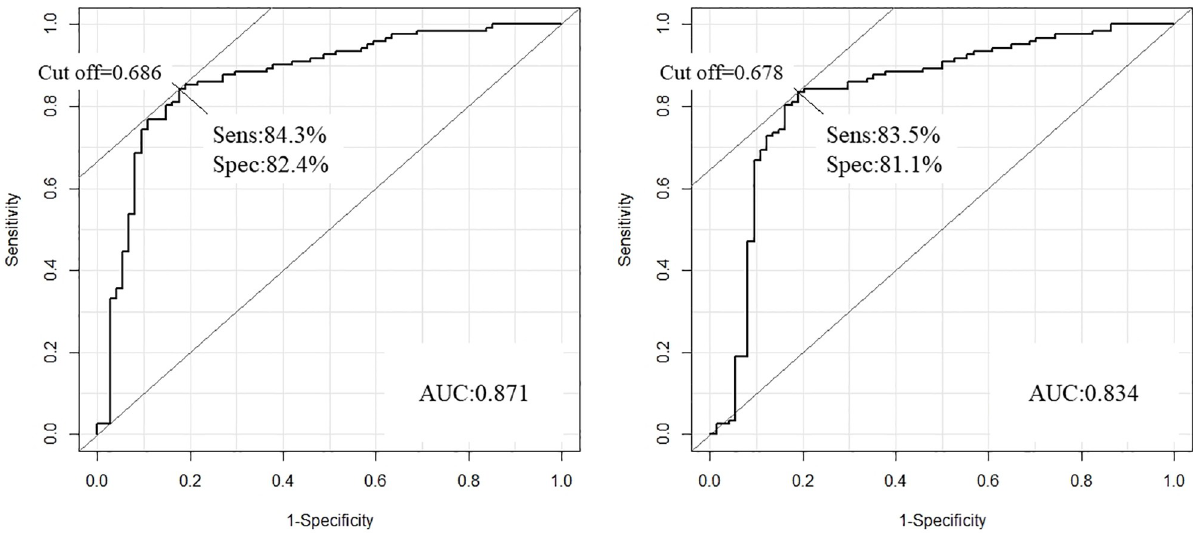
Fig 3. ROC curves of the BrS prediction model using miR-23a-3p, miR-423a-3p, and miR-223–3P. The miR-23a-3p, miR-423a-3p, and miR-223– 3P remained as independent predictors for BrS patients. The ROC curve using these three miRNAs showed good discrimination of the BrS patients from the controls with an area under the curve (AUC) of 0.871 and a sensitivity and specificity of 84.3% and 82.4%, respectively (Fig 3, left). Internal validation was performed by the leave-one-out cross-validation technique. The AUC based on cross-validation was 0.834 with a sensitivity and specificity of 83.5% and 81.1%,